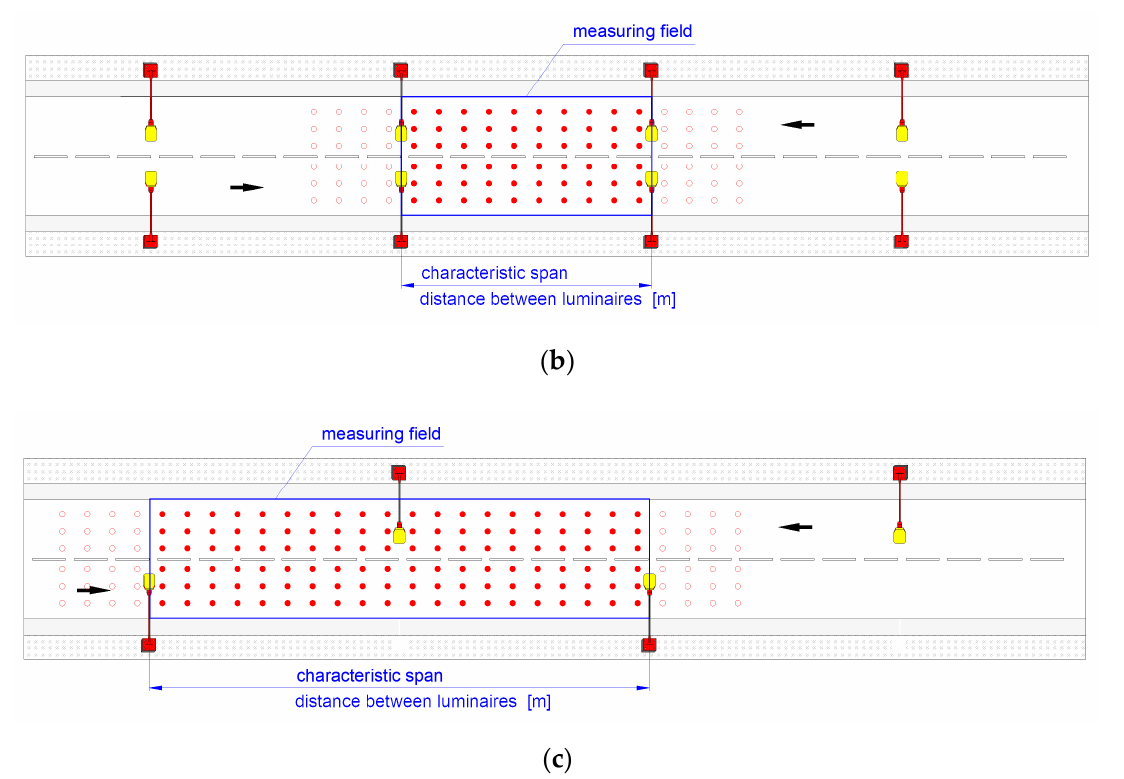
Figure 1. Typical luminaire arrangements ( a ) single-sided, ( b ) opposite, ( c ) alternate.